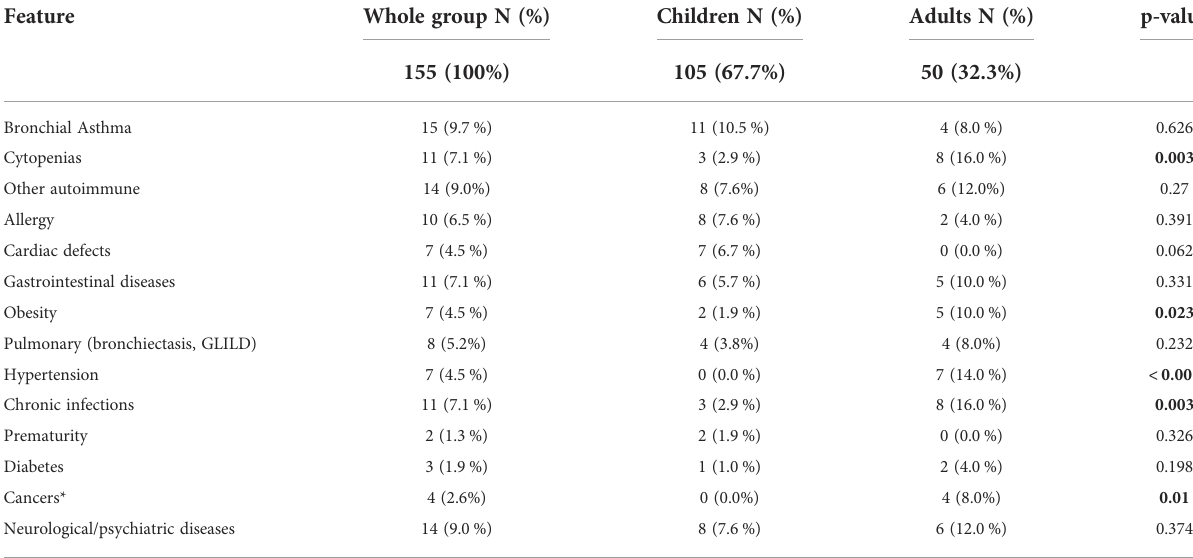
TABLE 2 Analysis of comorbidities in the presented group of patients with inborn errors of immunity (IEI), divided into immunological and non- immunological.